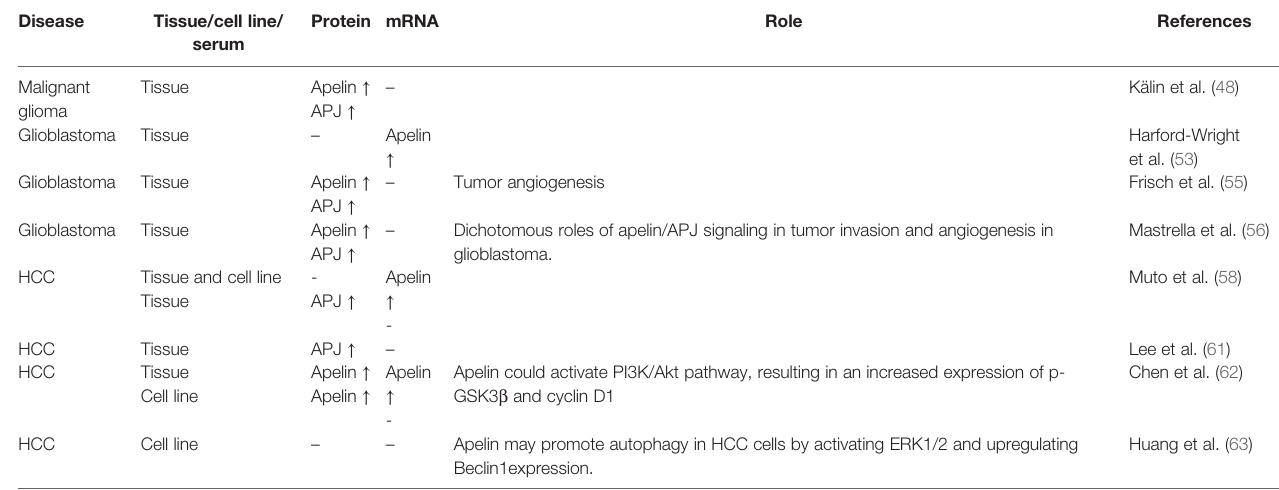
TABLE 3 | Expression and role of apelin/APJ signaling in brain tumor and